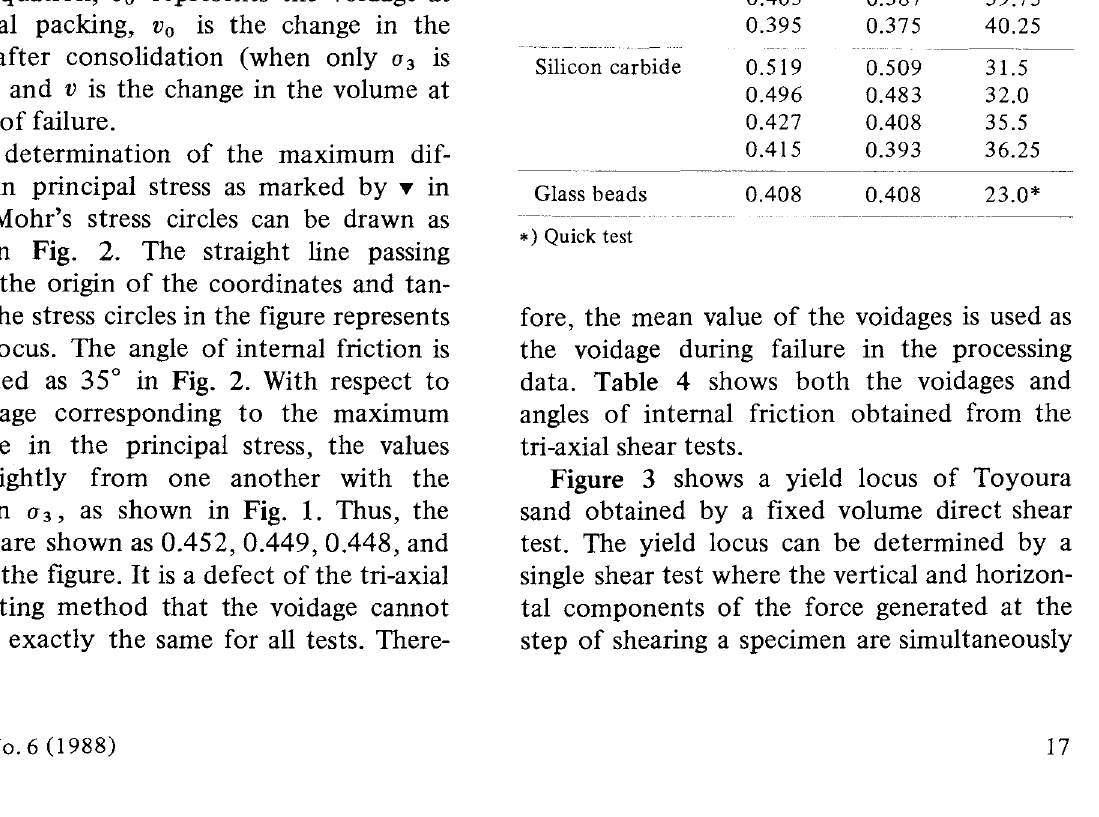
Fig. 1 The result of the tri-axial shear tests on Toyoura sand